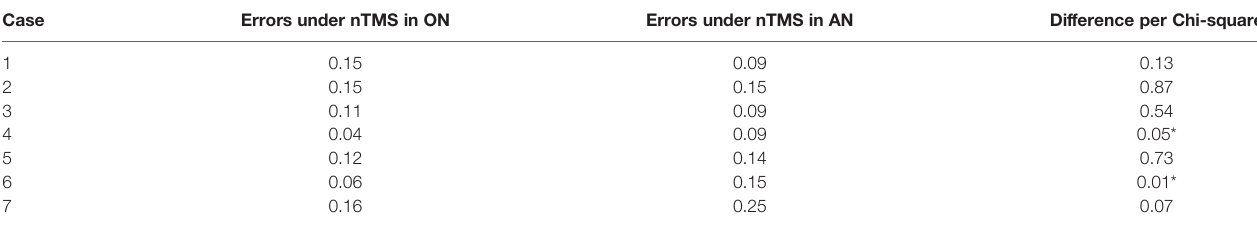
TABLE 2 | Proportion of induced errors during nTMS mapping of the left hemisphere with object naming (ON) and action naming (AN). Case Errors under nTMS in ON Errors under nTMS in AN Difference per